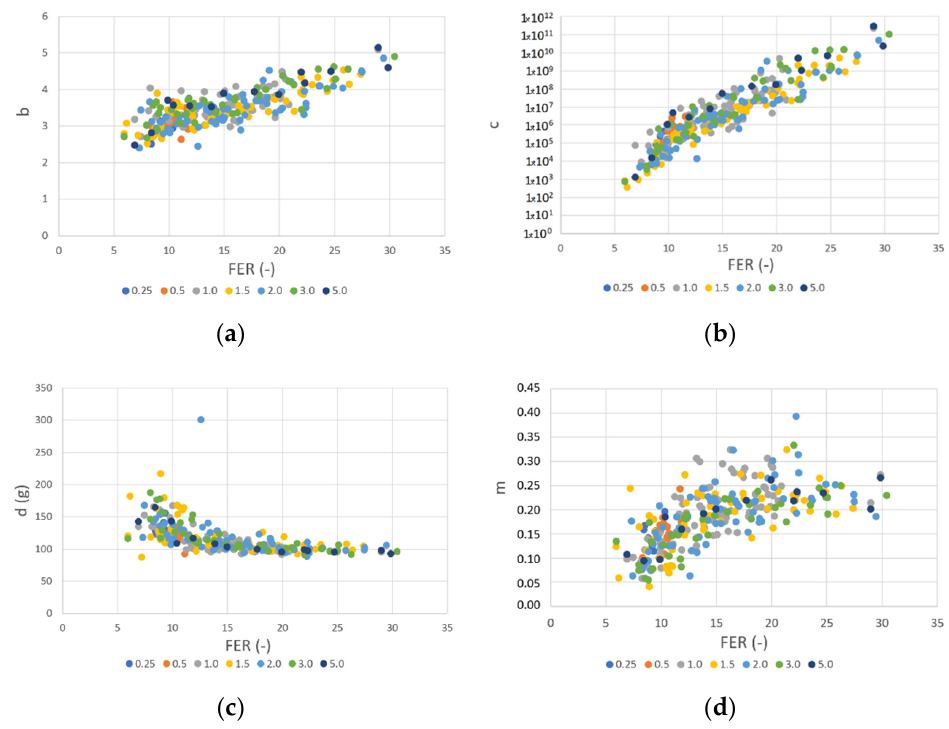
Figure 8. Asymmetric sigmoid parameters vs. FER for different liquid generator concentrations ( a – d ).